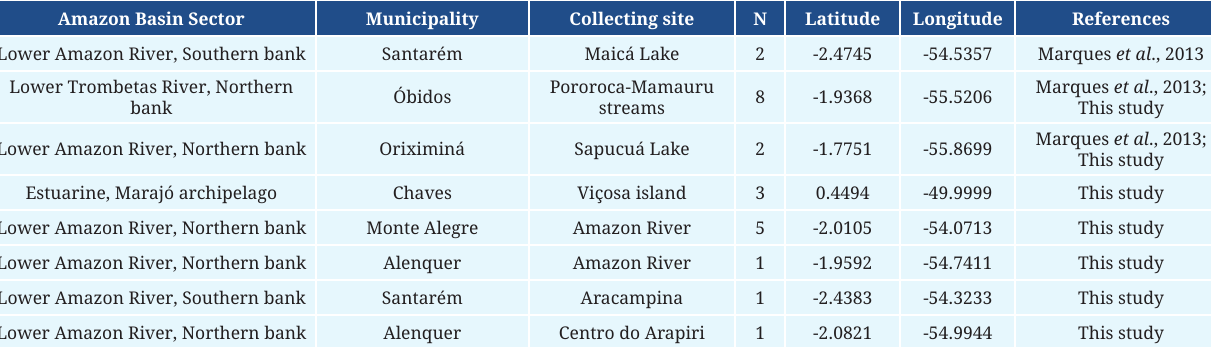
TABLE 1 | Detailed geographic information of new and former records of Hoplias misionera in Amazon Basin. N = number of specimens collected at each